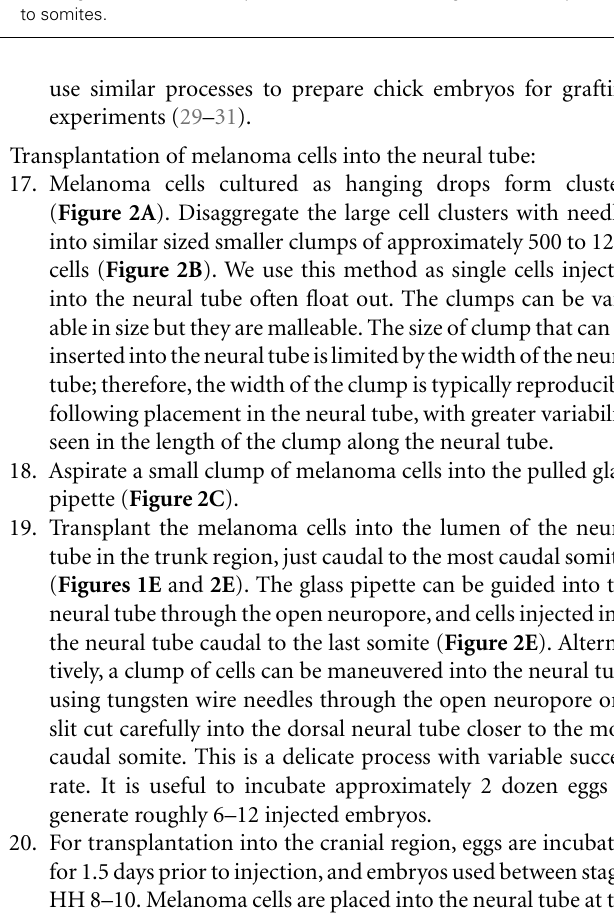
FIGURE 1 | Preparing egg for transplantation . (A,B) Create a window in the eggshell and (C) inject with India ink to better visualize the embryo. (D) Perform staging of the embryo by counting the number of somites. (E) An E2.5, or HH stage 14 embryo, showing the location of the transplanted